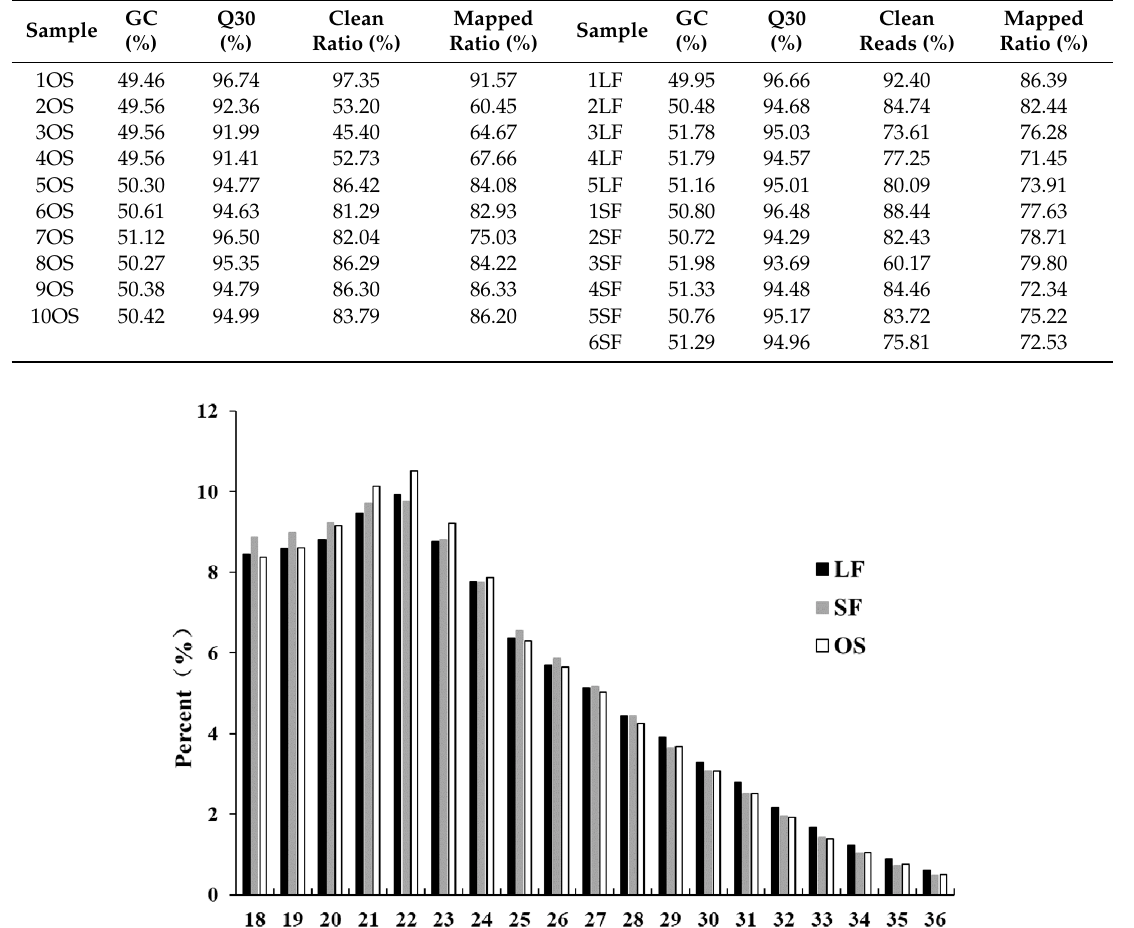
Table 1. Quality control of the small RNA ‐ seq data.